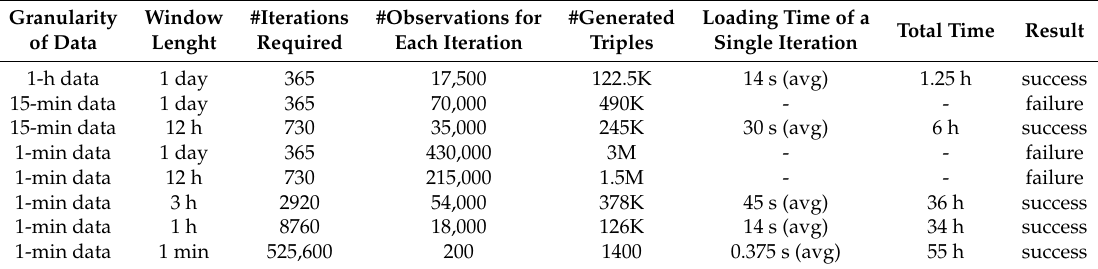
Table 3. Loading process performance for 1-year data under different granularity and window length conditions.